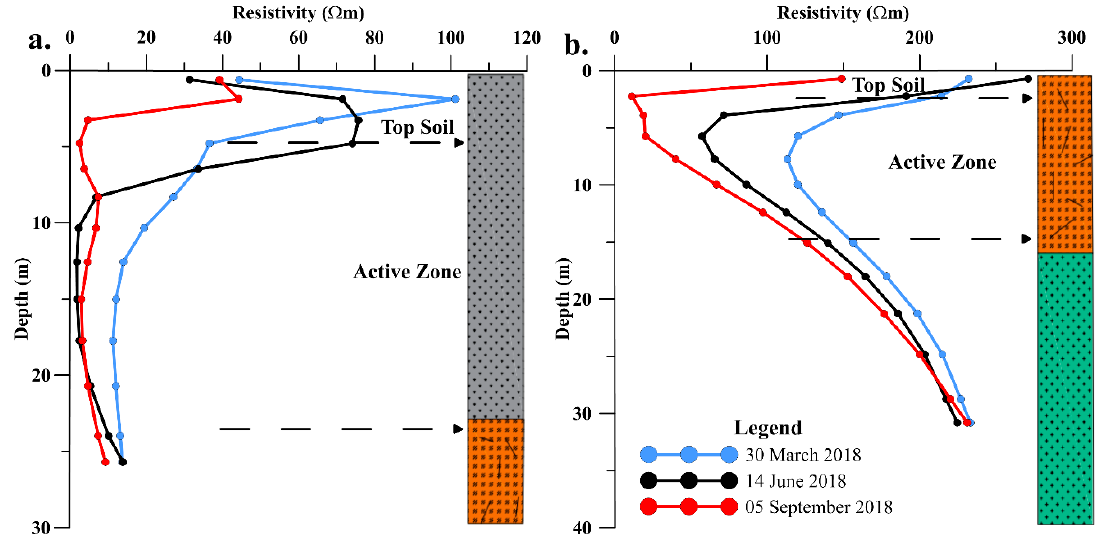
Figure 9. Showing the resistivity log extracted at an 81 m distance (Figure 6 and Figure 8). Top soil is characterized by root and soil interaction and the active zone is characterized by uniform resistivity change. ( a ) Resistivity log of line one; ( b ) Resistivity log of line two.